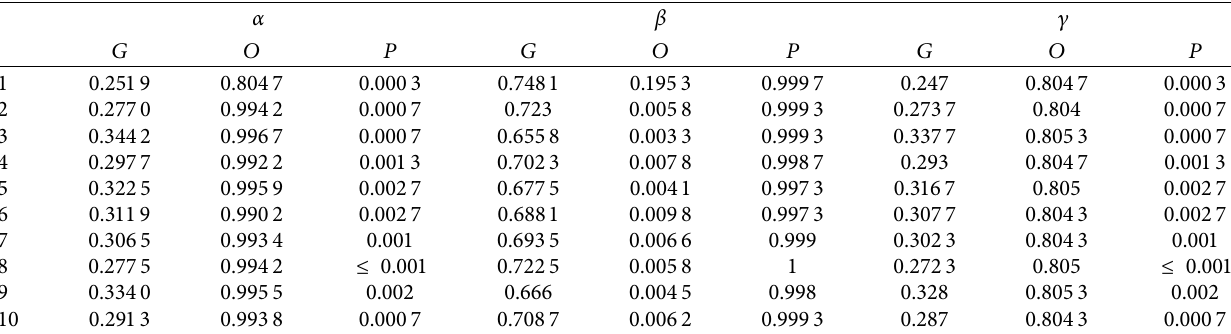
Table 7: Uncertainty measurement on “own-data